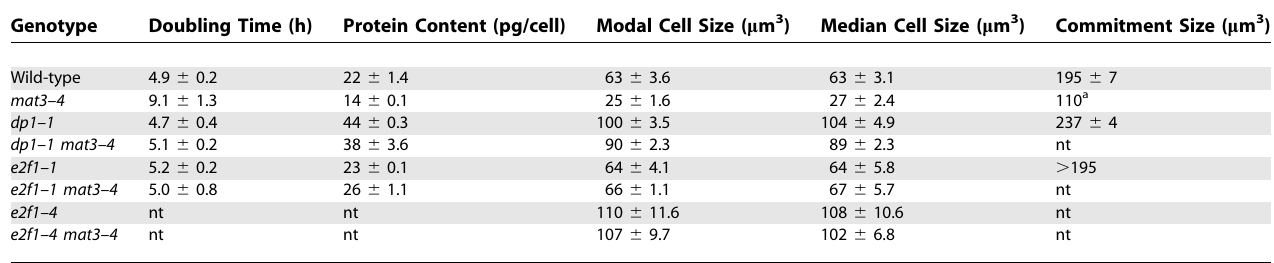
Protein content, modal cell sizes, and median cell sizes were determined for cultures that were dark-shifted after growth in continuous light. Mass doubling time was determined for cells growing exponentially in continuous light. Standard errors were derived from three independent cultures for doubling time analysis, two independent cultures for protein